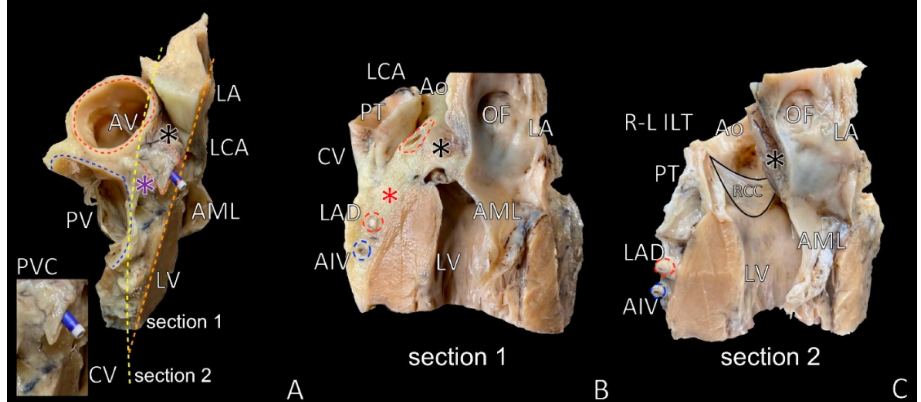
Figure 4. Photographs of the same cadaveric heart specimen dissected at two different lev- els showing spatial relationships between left ventricular summit (LVS), coronary vessels and aortic valve components. ( A ) Block of heart showing section lines through the LVS area; ( B ) Section 1, cut through the anterior interventricular groove (along the LVS septal margin); ( C ) Section 2, cut through the septal summit and the left coronary cusp of aortic valve. Violet asterisk = septal summit, black asterisk = aortic–mitral continuity, red asterisk = inaccessible area, Ao = aorta, AIV = anterior interventricular vein, AML = anterior mitral leaflet, AV = aortic valve, CV = conus vein, LA = left atrium, LAD = left anterior descending artery, LCA = left coronary artery, LV = left ventricle, OF = oval fossa, PT = pulmonary trunk, PV = pulmonary valve, PVC = posterior vein of conus, R-L ILT = right–left interleaflet triangle, RCC = right coronary